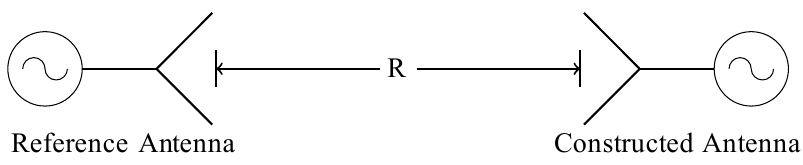
Figure 5. Experimental arrangement for the gain measurement.